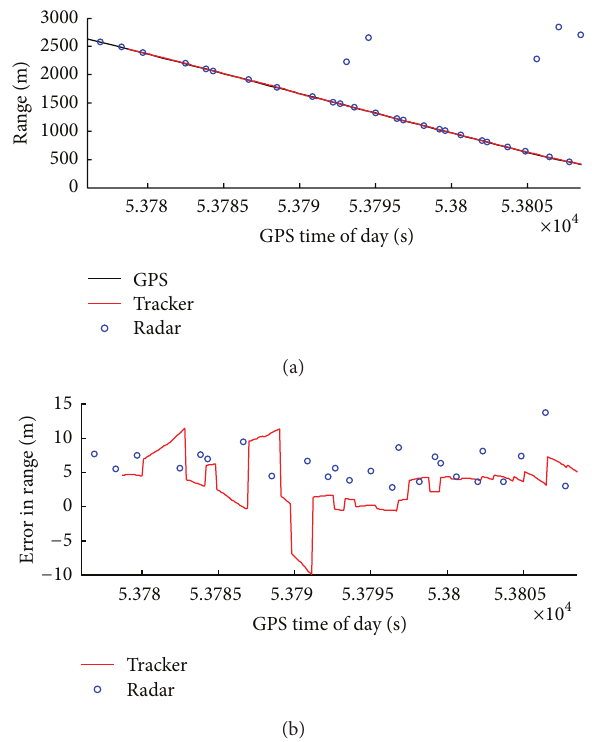
Figure 7: Intruder range (GPS, tracker, and radar) and relative estimation errors (tracker and radar with respect to GPS) as a function of GPS time in the considered scenario.